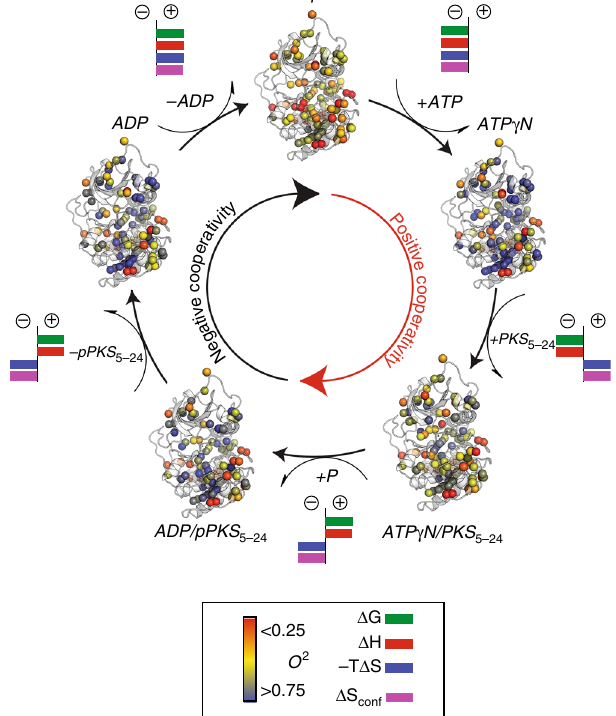
Fig. 2 Changes of conformational entropy of PKA-C along the coordinate of reactions. Ribbon representation of the different ligated conformations of PKA-C along the coordinate of reactions as obtained from X-ray crystallography: apo (PDB code: 4NTS), binary complex (ATP γ N-bound, PDB code: 1BKX), ternary complex (ATP γ N and PKS 5 – 24 bound, PDB code: 4DG0), ternary/exit complex (ADP and pPKS 5-24 bound, PDB code: